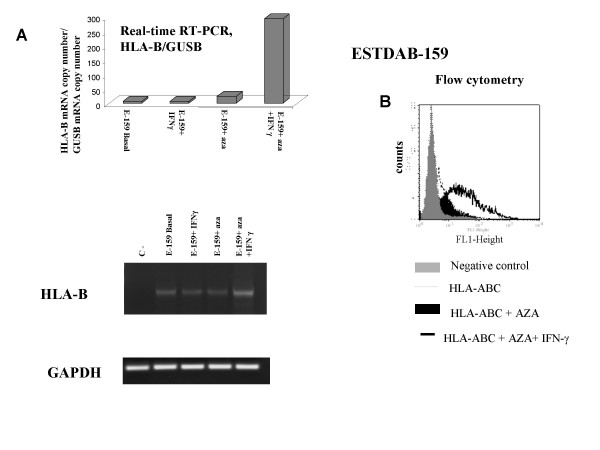
5-Aza-2-deoxycytidine (5-dAzaC) recovers IFN-γ mediated HLA-class I inducibility in ESTDAB-159 melanoma cells. Cells were untreated or pretreated for 7 days with 3 μM 5-dAzaC and/then untreated or incubated with 800 U/ml IFN-γ for 48 hrs. HLA class I expression before and after treatment with 5-dAzaC was determined by flow cytometry analyzes of HLA-ABC surface expression using W6/32 monoclonal antibody (B), and by quantitative RT-PCR (A). Results of HLA-B expression are normalized against GUSB expression (HLAB/GUSB).